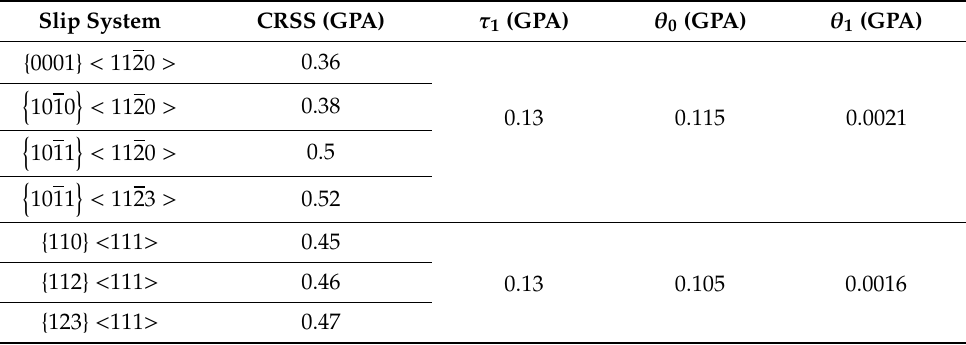
Table 2. The critical resolved shear stress (CRSS) and hardening coe ffi cient of slip systems [30]. Slip System CRSS (GPA) τ 1